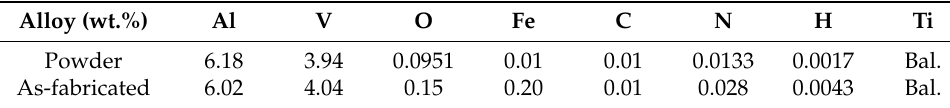
Figure 1. ( a ) SEM images of the Ti-64 powders used in this study. ( b ) Schematic of SLMed Ti-64 tensile samples; ( c ) schematic of the build directions of tensile specimens. Table 1. Chemical composition of Ti-64.